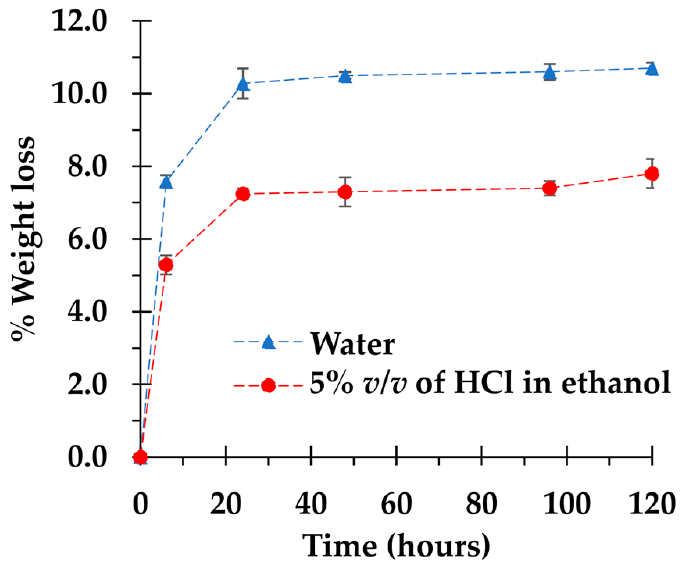
Figure 9. Stability of BDP5 system in water and 5% v / v of HCl in ethanol.